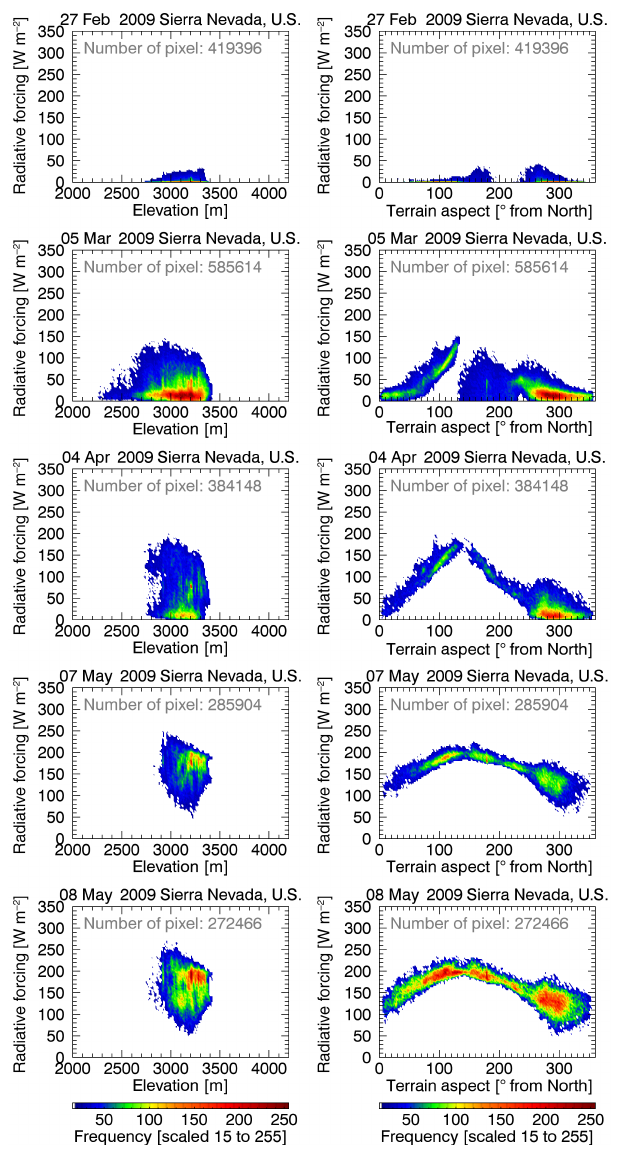
Figure 15. Same as Fig. 14 but for the Rocky Mountains in spring